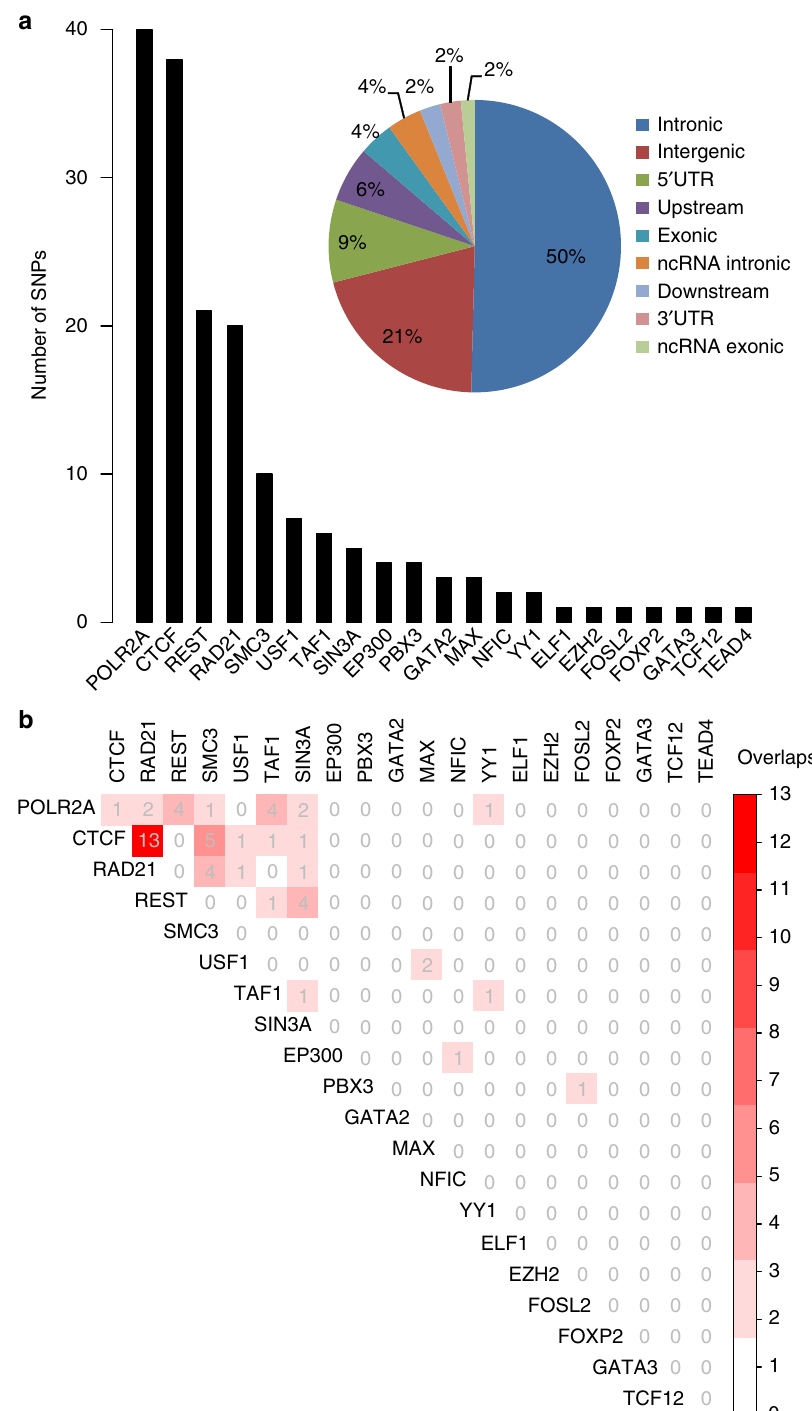
Fig. 3 Transcription factors (TFs) disrupted by schizophrenia risk single-nucleotide polymorphisms (SNPs). a Left panel, The box plot shows the number of schizophrenia risk SNPs disrupting the binding of individual TF based on matched position weight matrices (PWMs) from chromatin immunoprecipitation and sequencing (ChIP-Seq) and PWM database. a Right panel, The distribution of the 132 identi fi ed TF binding – disrupting SNPs in the human genome. Most of the identi fi ed regulatory SNPs were located in intronic and intergenic regions. b The number of SNPs disrupting the binding of two TFs simultaneously. In addition to disruption of individual TF, we also found that some of the identi fi ed regulatory SNPs disrupt the binding of two TFs. Of note, 13 risk SNPs disrupted the binding of CTCF and RAD21